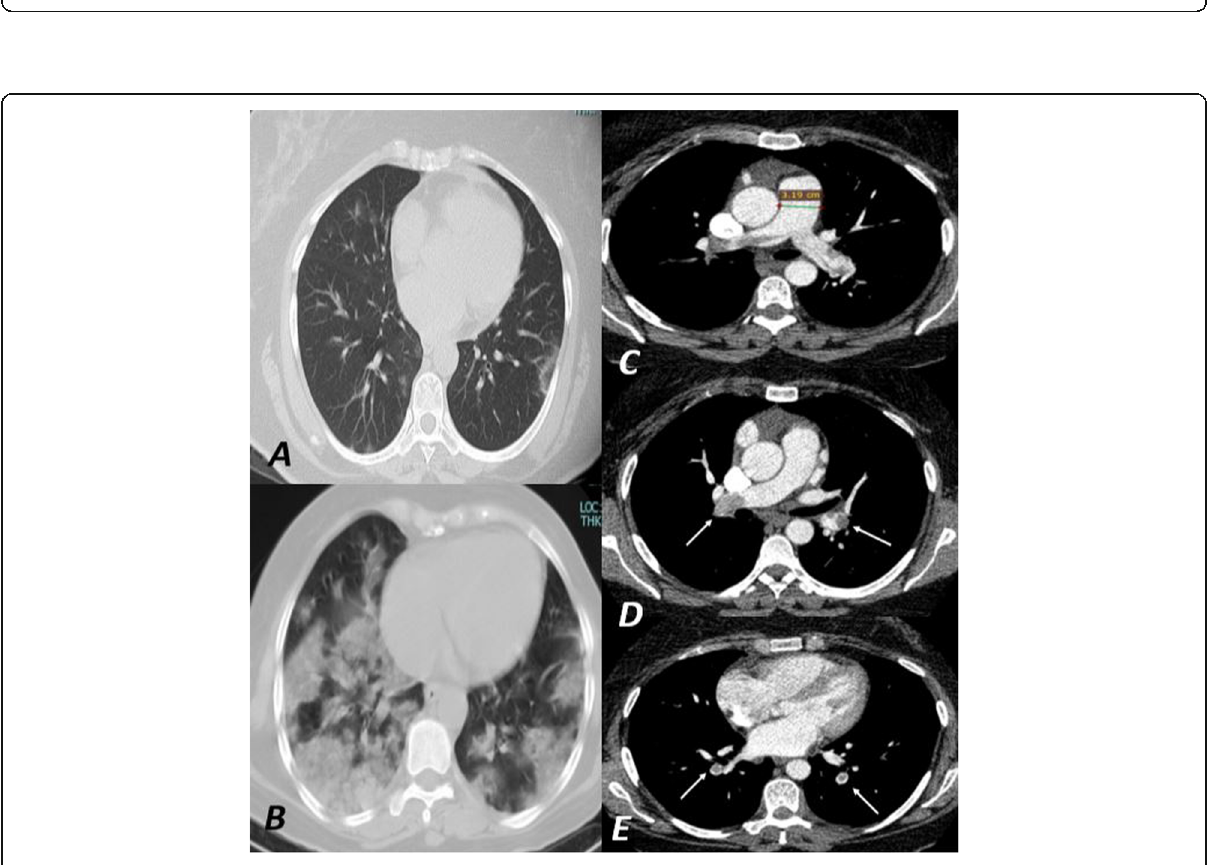
Fig. 4 A female patient 48 years old known case of COVID-19 infection as confirmed by PCR. She complained of chest pain 12 days after the onset of the disease and her oxygen saturation level showed a gradual decrease. Her D-dimer level was 1.1 μ g/ml and repeated to show a gradual increase reaching 1.8 μ g/ml. a The axial CT image of the baseline study of the patient showing a few bilateral peripheral patchy areas of ground-glass opacity while b was her follow-up after a recent complaint showing a progressive course of the disease extension. A pulmonary embolism was suspected for which CTPA was done and revealed a saddle pulmonary embolism involving the right and left main pulmonary arteries extending into the lobar branches (white arrow in image d and e ). Positive RV strain was identified with dilated main pulmonary artery (31.9 mm in image c ), reversed RV/LV ratio, and leftward deviation of the IV septum (image e